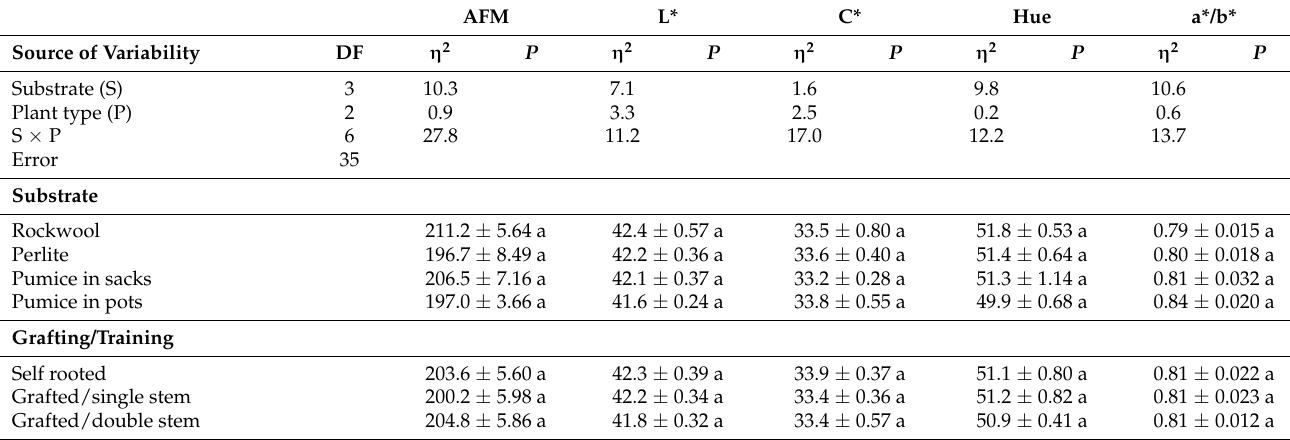
Table 5. Analysis of variance for average visual quality traits (fruit mass: AFM, luminance: L*, chroma: C*, hue, a*/b*) of tomato fruit harvested on 31 July. The fruit was obtained from self-rooted ‘Beef Bang F1’, ‘Beef Bang F1’ grafted onto ‘Defensor’, trained in single or double stem and grown hydroponically in four substrates (rockwool slabs, perlite in sacks, pumice in sacks and pumice in pots) in a